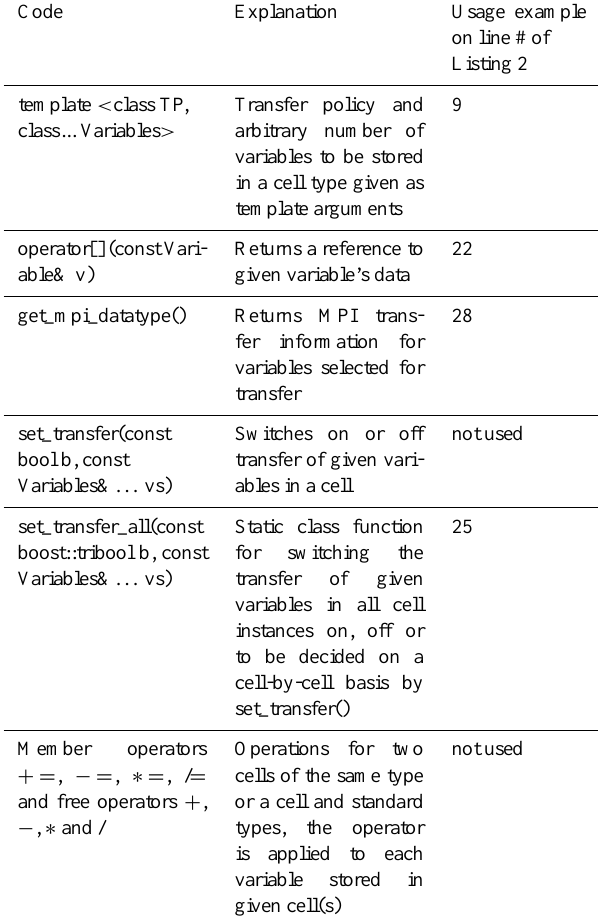
Table 1. Summary of application programming interface of generic simulation cell class. Listed functions are members of the cell class unless noted